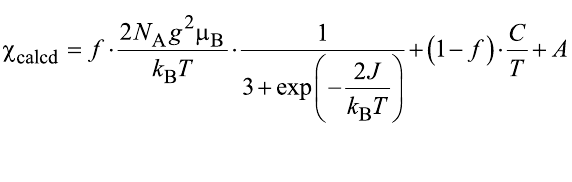
1 – 5 , the spin susceptibility comes from Cu(II) ( S =